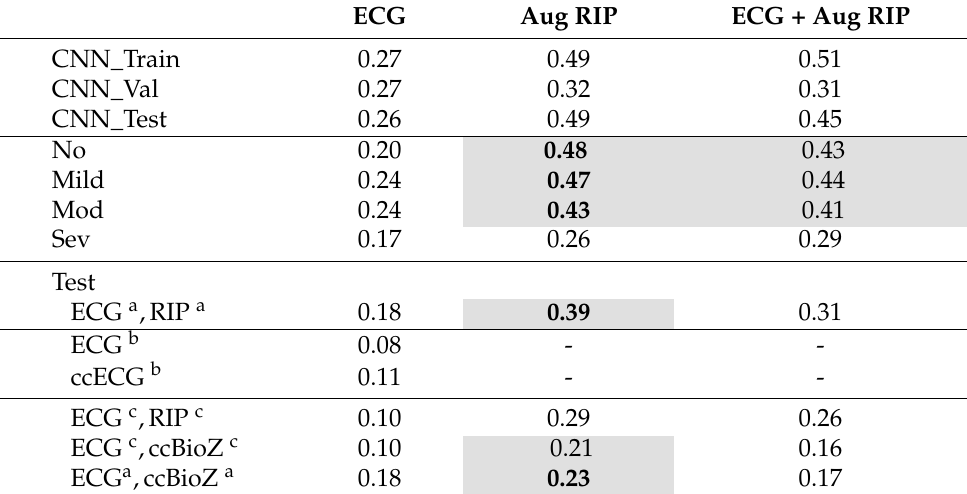
Table 3. Mean Cohen’s Kappa scores of sleep–wake classification using the unimodal (ECG, Aug- mented RIP) and multimodal (ECG with Augmented RIP) networks. These networks were trained on PSG recordings of patients with AHI < 10 and tested on patient data with varying AHI, as well as on unobtrusive ccECG and ccBioZ data. The main results are indicated in grey, and the best results are given in